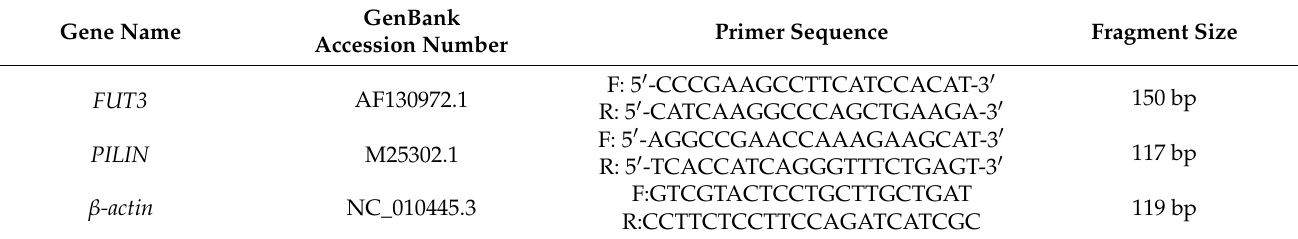
Table 2. Real-time PCR primers and